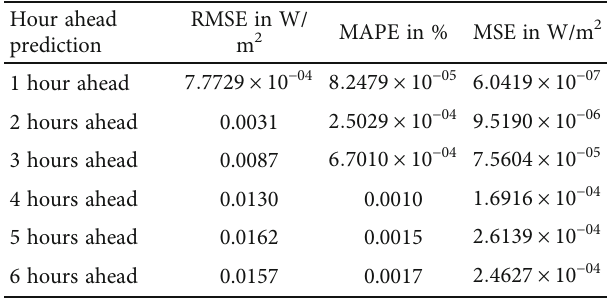
Table 1: Proposed CLSTMN-based results on sunny datasets for di ff erent hours ahead prediction of solar irradiance.